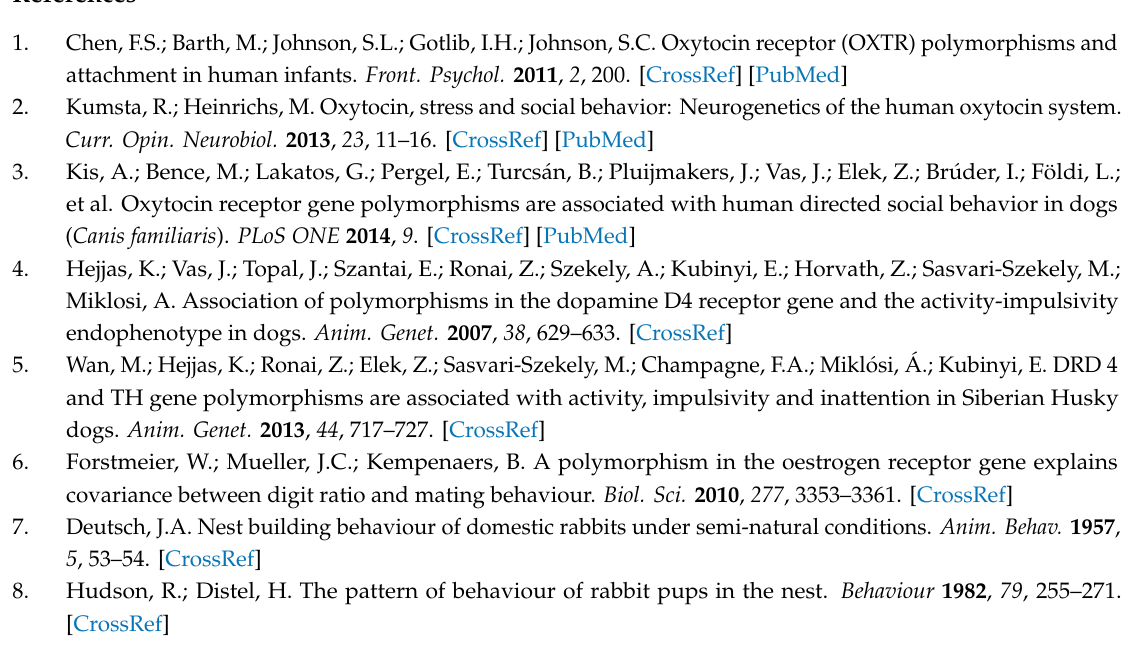
Table S1: The raw data of the